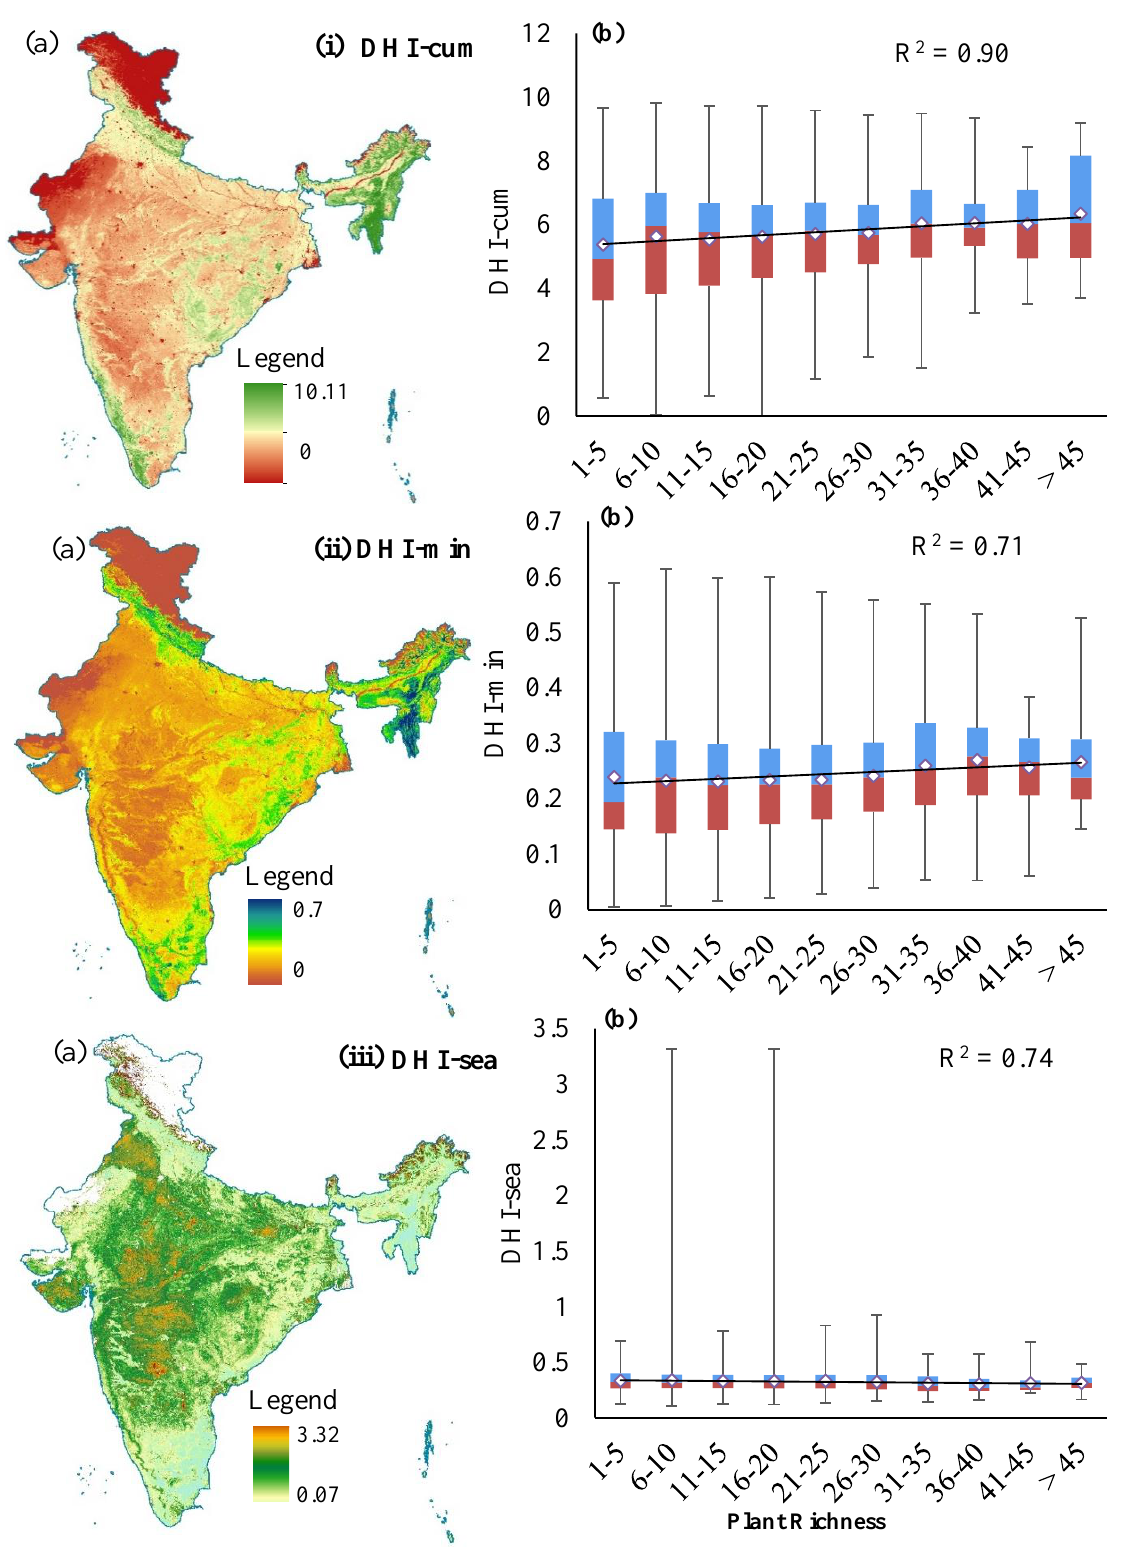
Figure 9. The three DHI components ( i ) DHI-cum; ( ii ) DHI-min, and ( iii ) DHI-sea were used: ( a ) to map the greenness variation for India, and ( b ) the box plots against the field-measured plant richness data from the four Biogeographic regions of India.